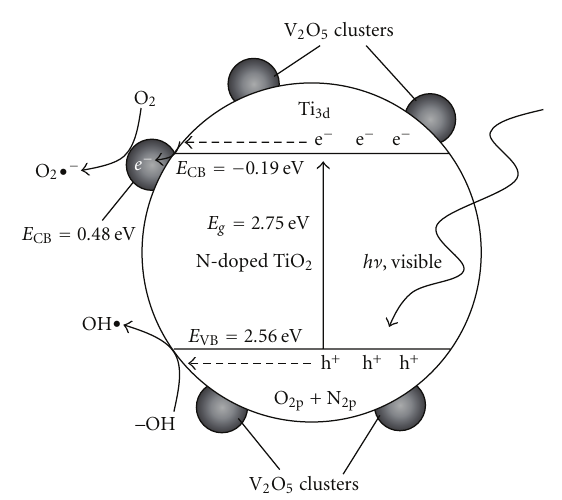
Figure 8: Schematic illustration for the enhanced charge transfer and separation in the V 2 O 5 cluster modified N-doped TiO 2 system under visible light